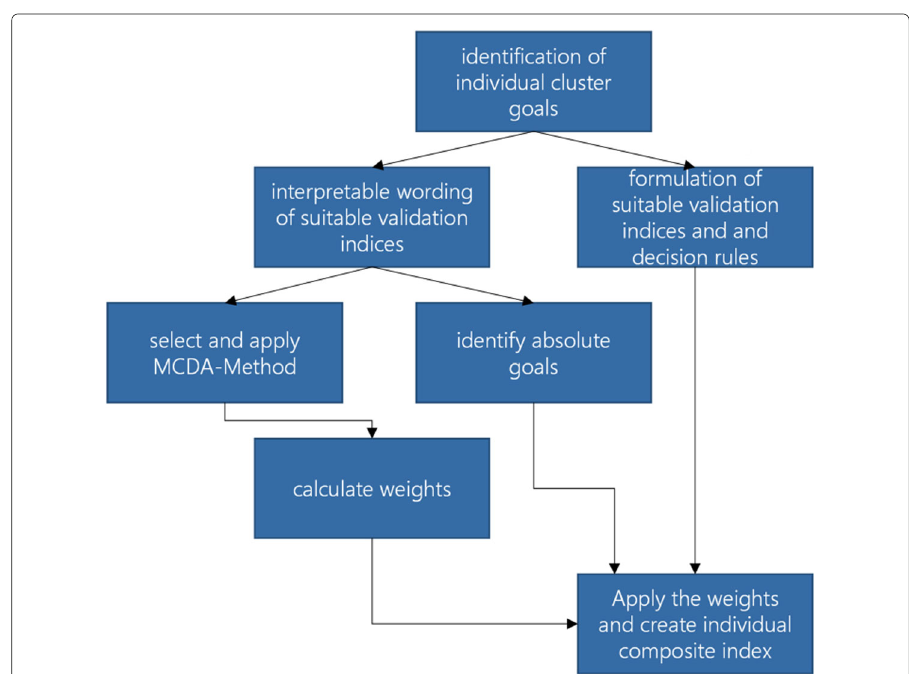
Fig. 2 Practical workflow for weighting of cluster